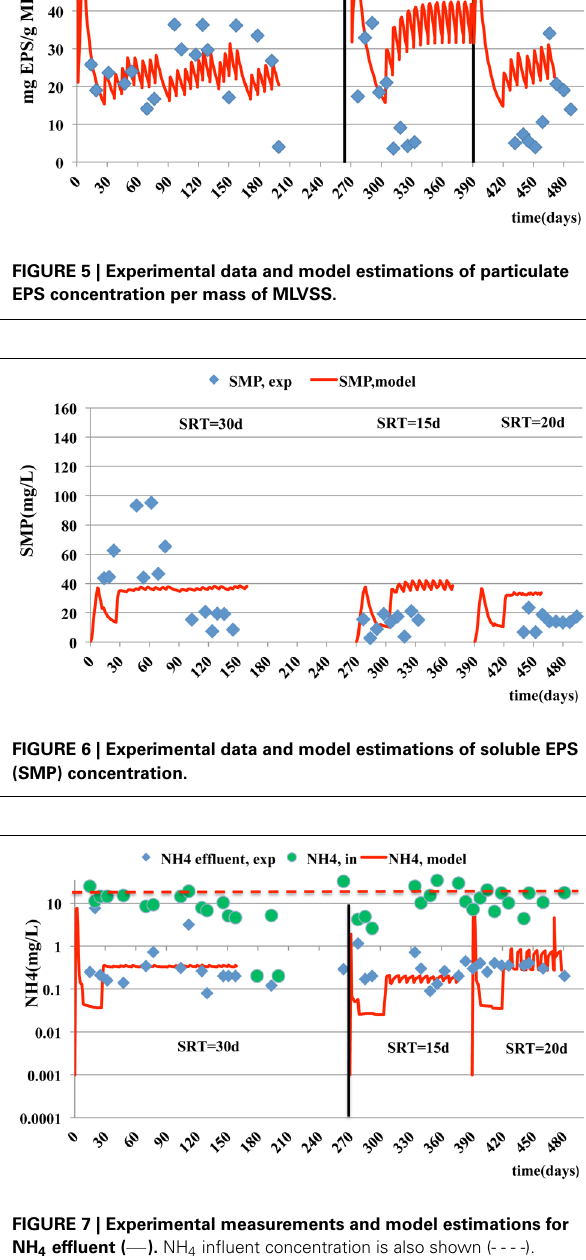
not in good agreement with the measurements. Chen et al.